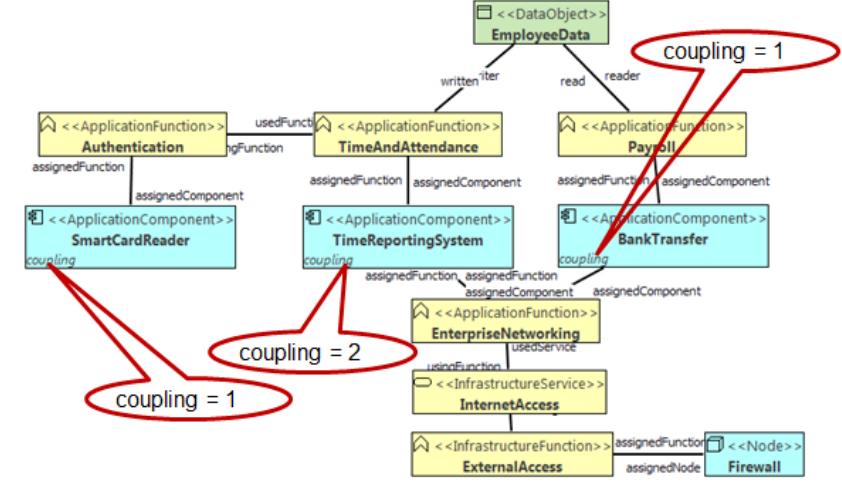
Figure 7. A simple MAPL coupling